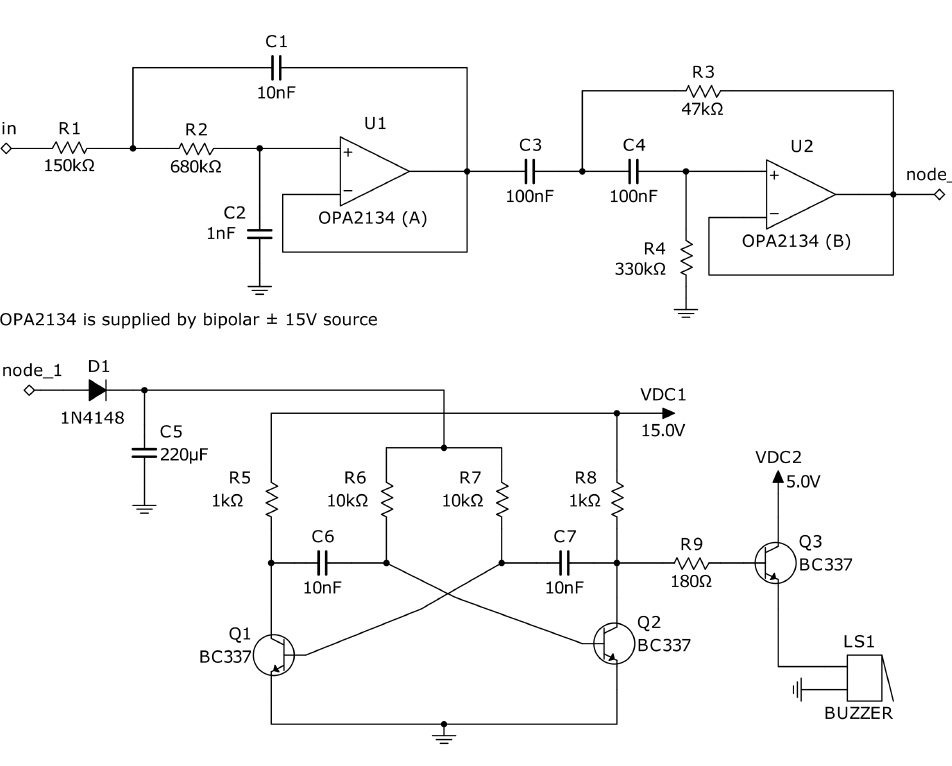
Figure 7. Electrical schematic of the analog Duffing oscillator mode detector. In the absence of chaotic oscillations at the input, it produces a very high tone. In the presence of a chaotic signal at the input, a low scroll-switching rate produces a low tone, and a high scroll-switching rate produces a high tone. The second type of detector converts the signal of a chaotic oscillator into a signal